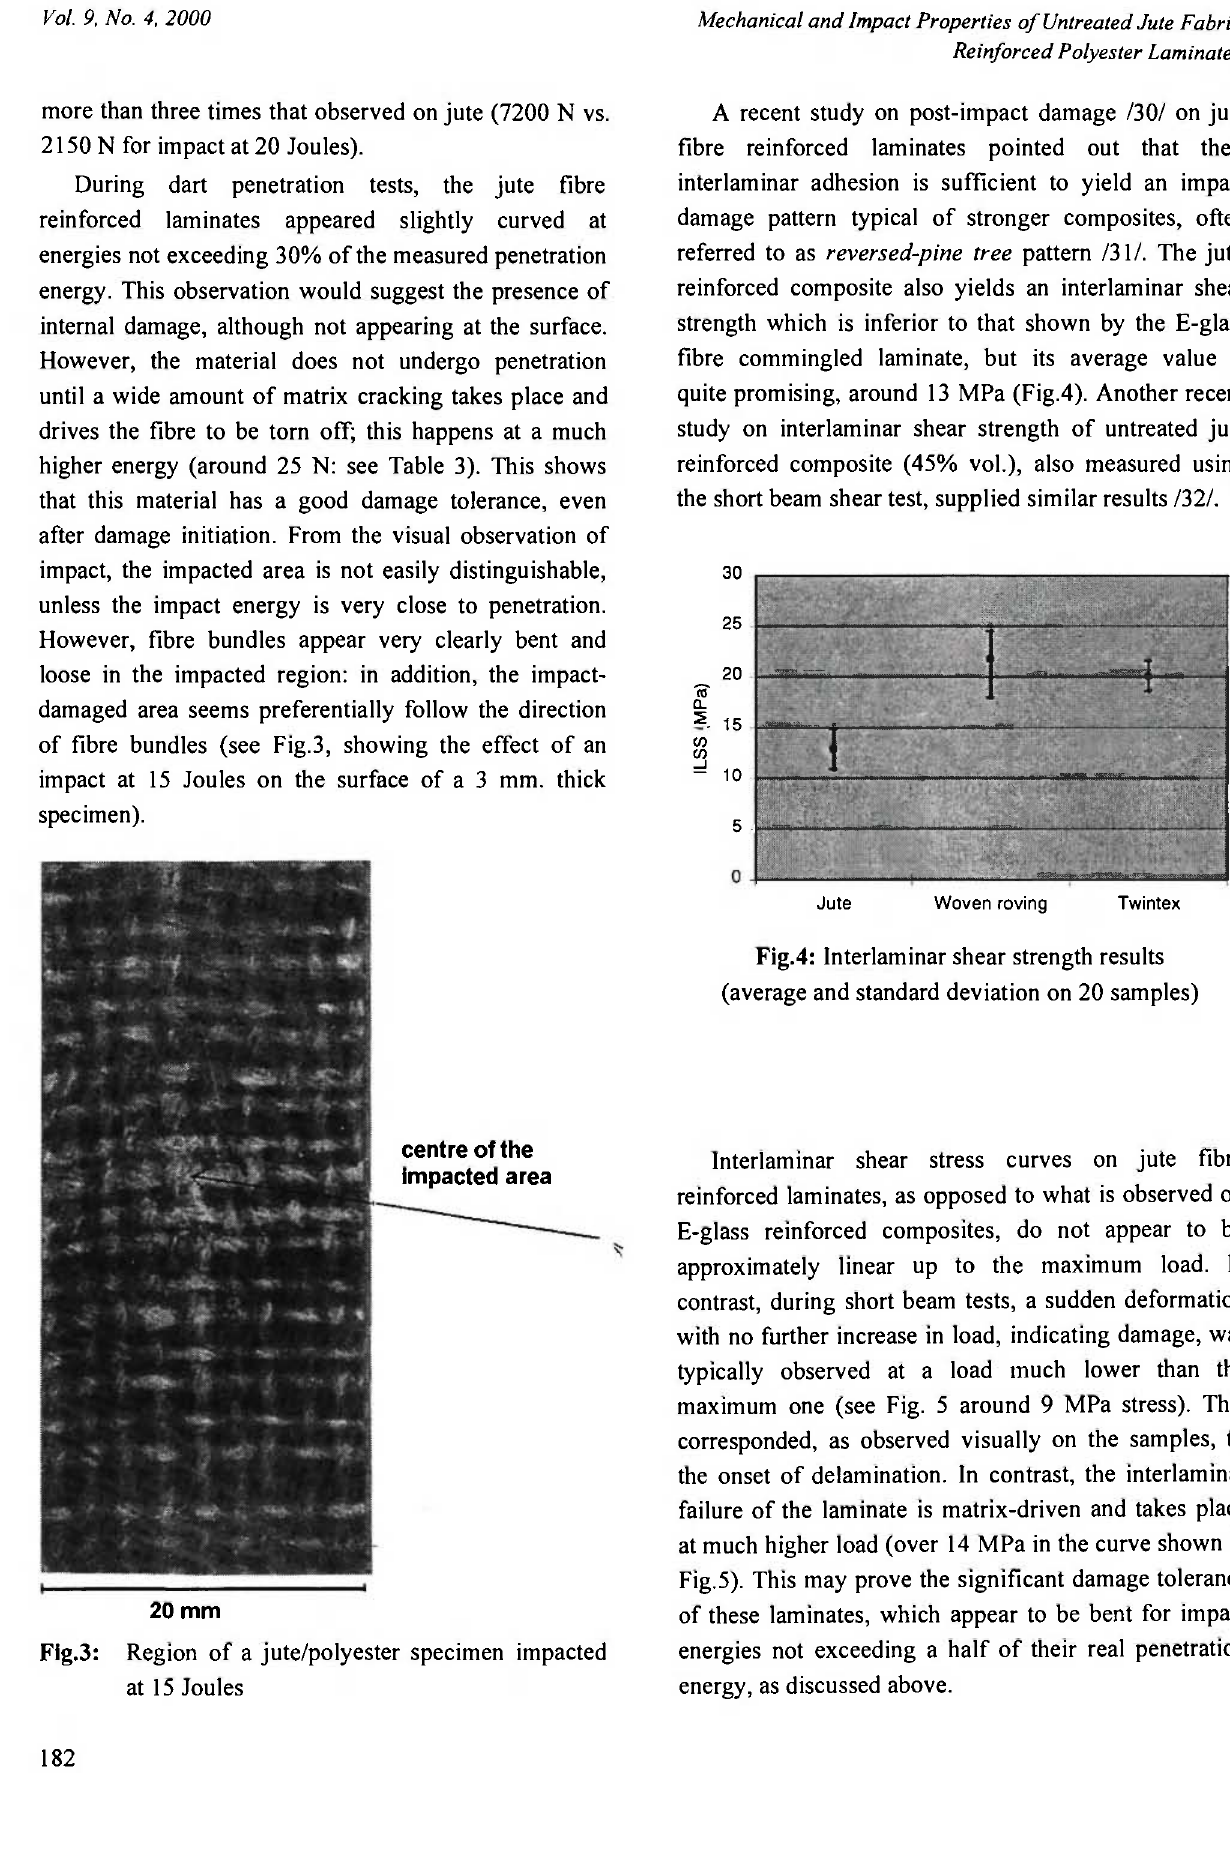
Fig.3: Region of a jute/polyester specimen impacted energies not exceeding a half of their real penetration at 15 Joules energy, as discussed